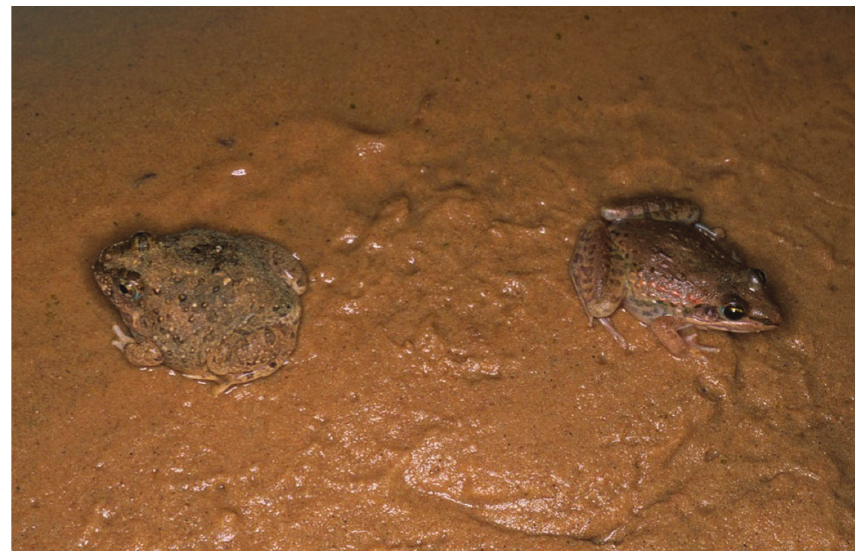
Figure 4. Tomopterna cryptotis and Ptychadena schillukorum (museum number: MNCN 42214, SVL = 31.8 mm) found in syntopy, Aleg, Mauritania (photo Rafael Márquez).